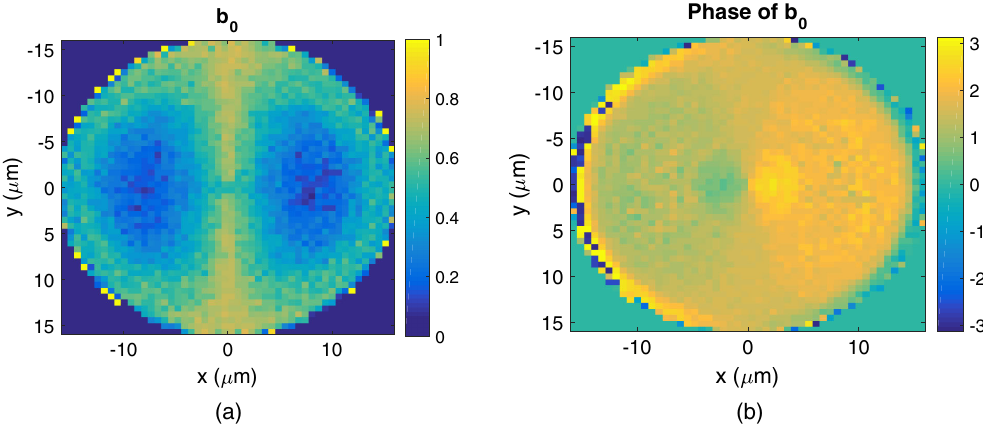
FIG. 6. (a) The bunching factor (b) and the relative phase in radians as a function of the transverse position in the